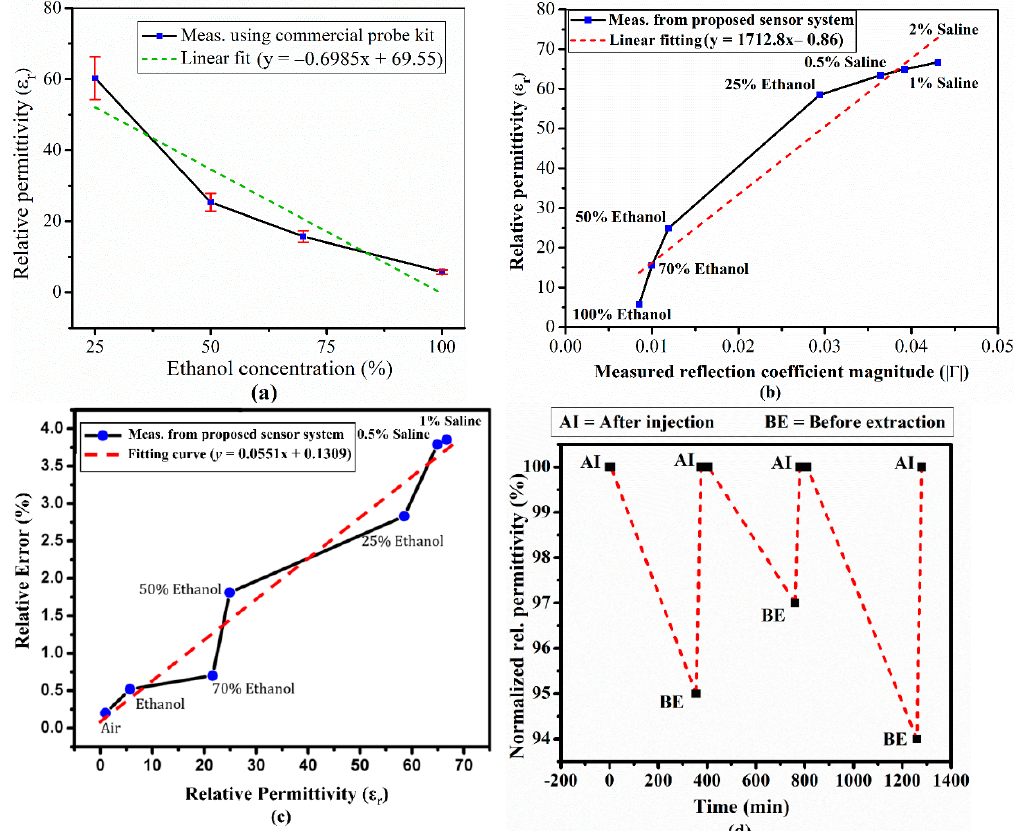
Figure 9. ( a ) Measured relative permittivity for four different ethanol concentrations using the commercial probe kit, ( b ) measured return loss with respect to relative permittivity using the proposed system, ( c ) permittivity relative error for 7 liquids using the proposed system, and ( d ) repeatability/stability for the proposed system (ethanol relative permittivity changed from 5.72 to 5.78 after being left in the microfluidic channels for 5 h).